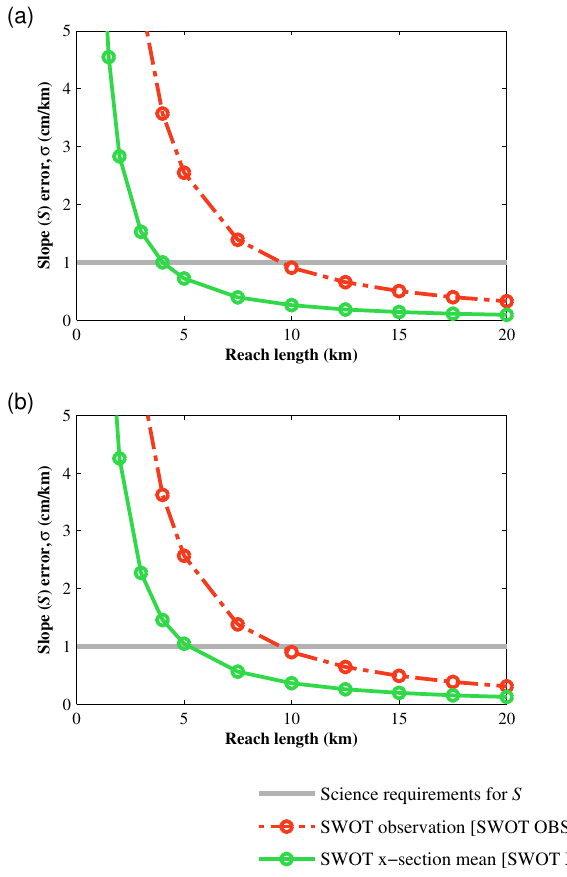
Figure 10. The effect of reach-length averaging on errors in the water-surface slope estimation for (a) the Solimões and (b) the Pu- rus rivers.